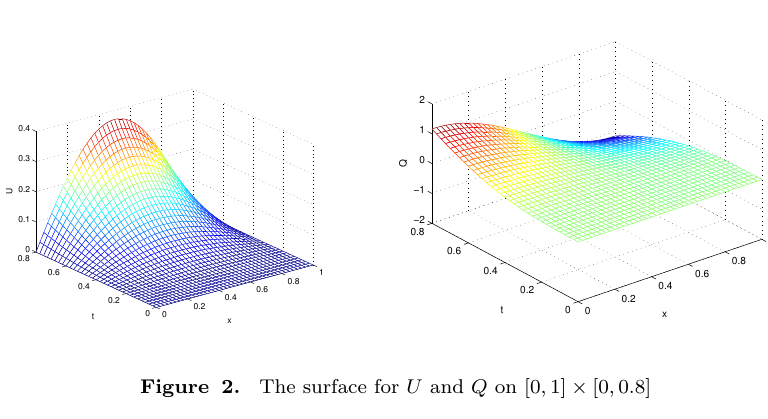
Figure 2. The surface for U and Q on [0 , 1] × [0 , 0 .